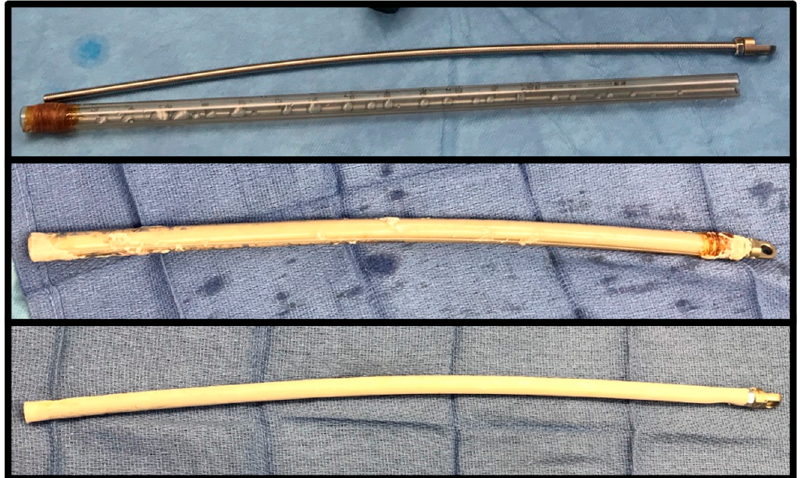
Figure 2. A PMMA-coated intramedullary nail can be fabricated using a chest tube or a threaded rod or guidewire. After mixing, the cement is injected into the chest tube and the rod is inserted. The tubing is then removed after the PMMA has hardened using a